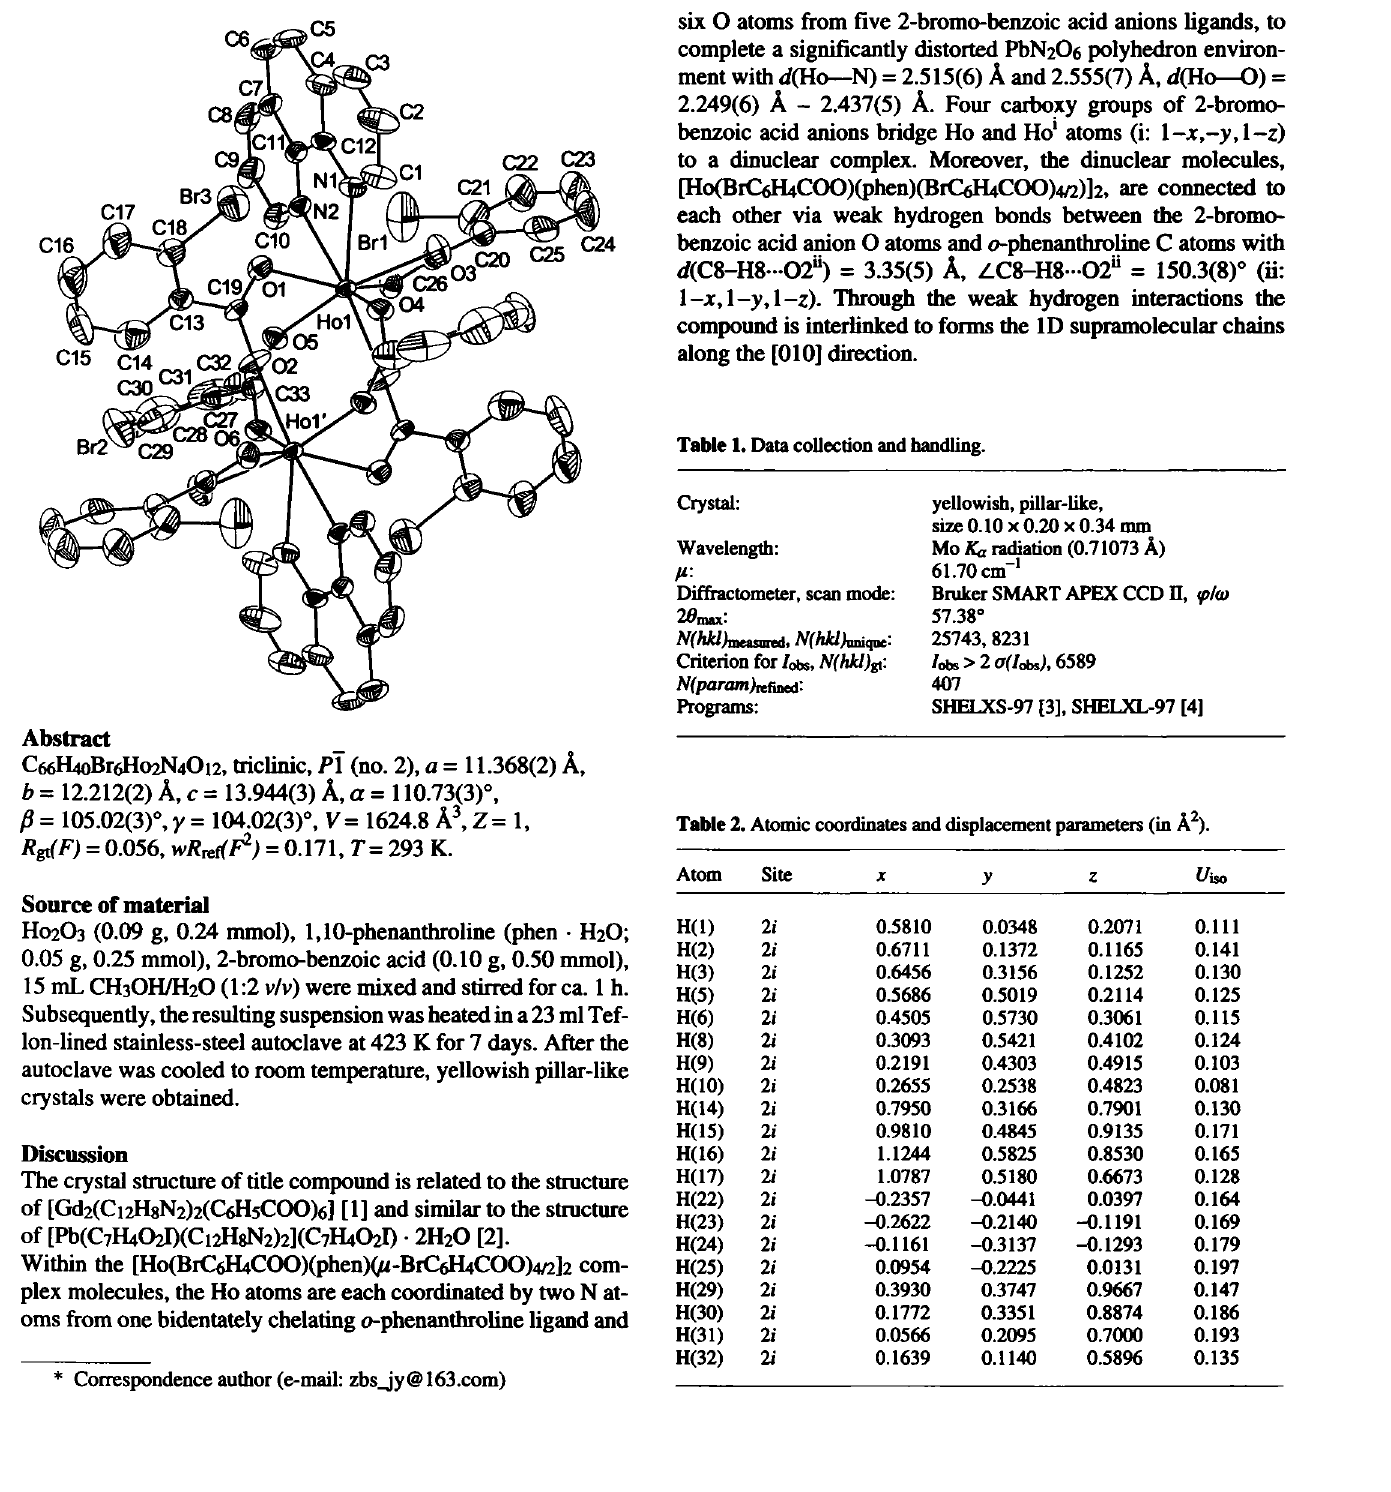
Table 2. Atomic coordinates and displacement parameters (in Ä 2